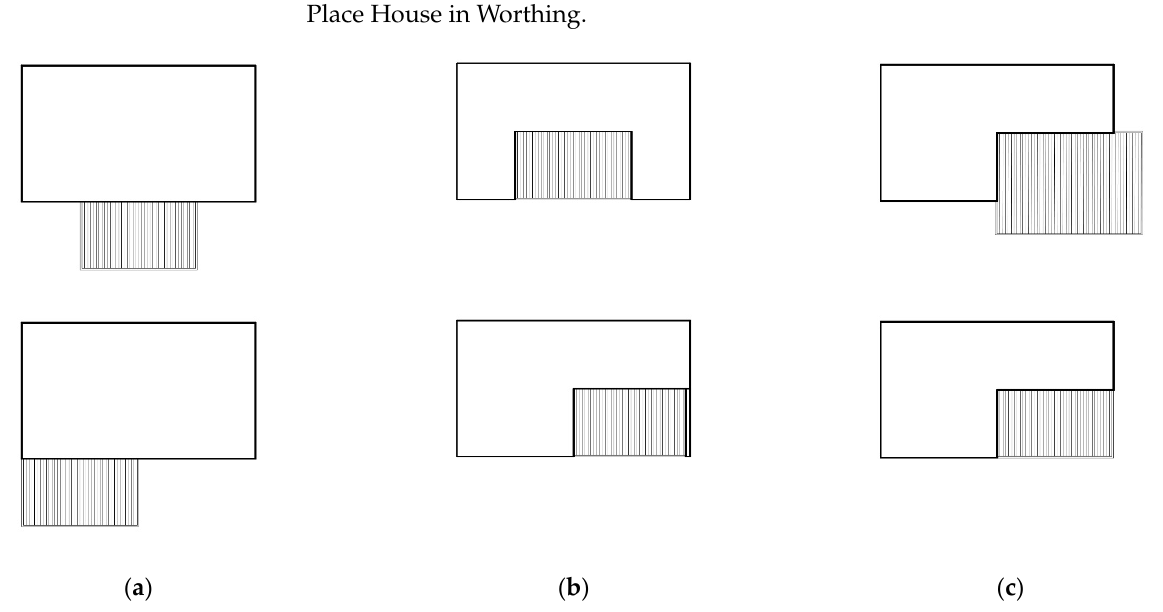
Figure 6. Extension in houses: ( a ) placed outside the building floorplan contour; ( b ) placed inside the building floorplan; and ( c ) placed in the corner (figure by the author).